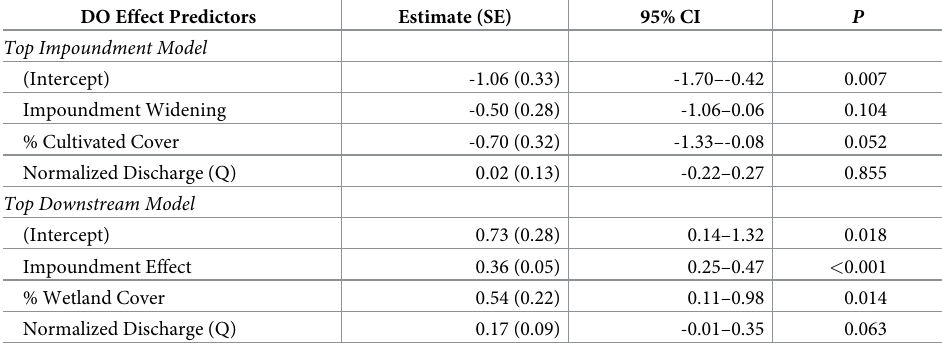
Table 7. Standardized parameter estimates for the two top-ranked candidate models explaining variation in impoundment and downstream dissolved oxygen (DO) effects before dam removal. Estimates of fixed effects are shown with standard errors (SE), 95% confidence intervals (CI), and p-values ( P